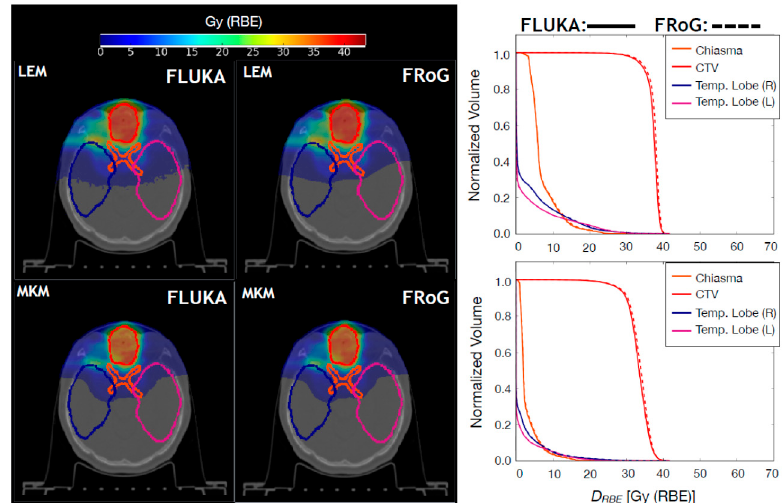
Figure 4. Upper panels: FLUKA and FRoG recalculated LEM-based D RBE distributions for a 12 C ion head case are displayed in the left and middle panel, respectively, together with the contours of four representative regions of interest: CTV, brainstem, and left/right temporal lobe. The LEM-based D RBE VH for the ROIs are shown in the right panel. Lower panels: FLUKA and FRoG recalculated MKM-based D RBE distributions for a 12 C ion head case are displayed in the left and middle panel, respectively, together with the contours of four regions of interest: CTV, brainstem, and left/right temporal lobe. The MKM-based D RBE VH for the ROIs are shown in the right panel.